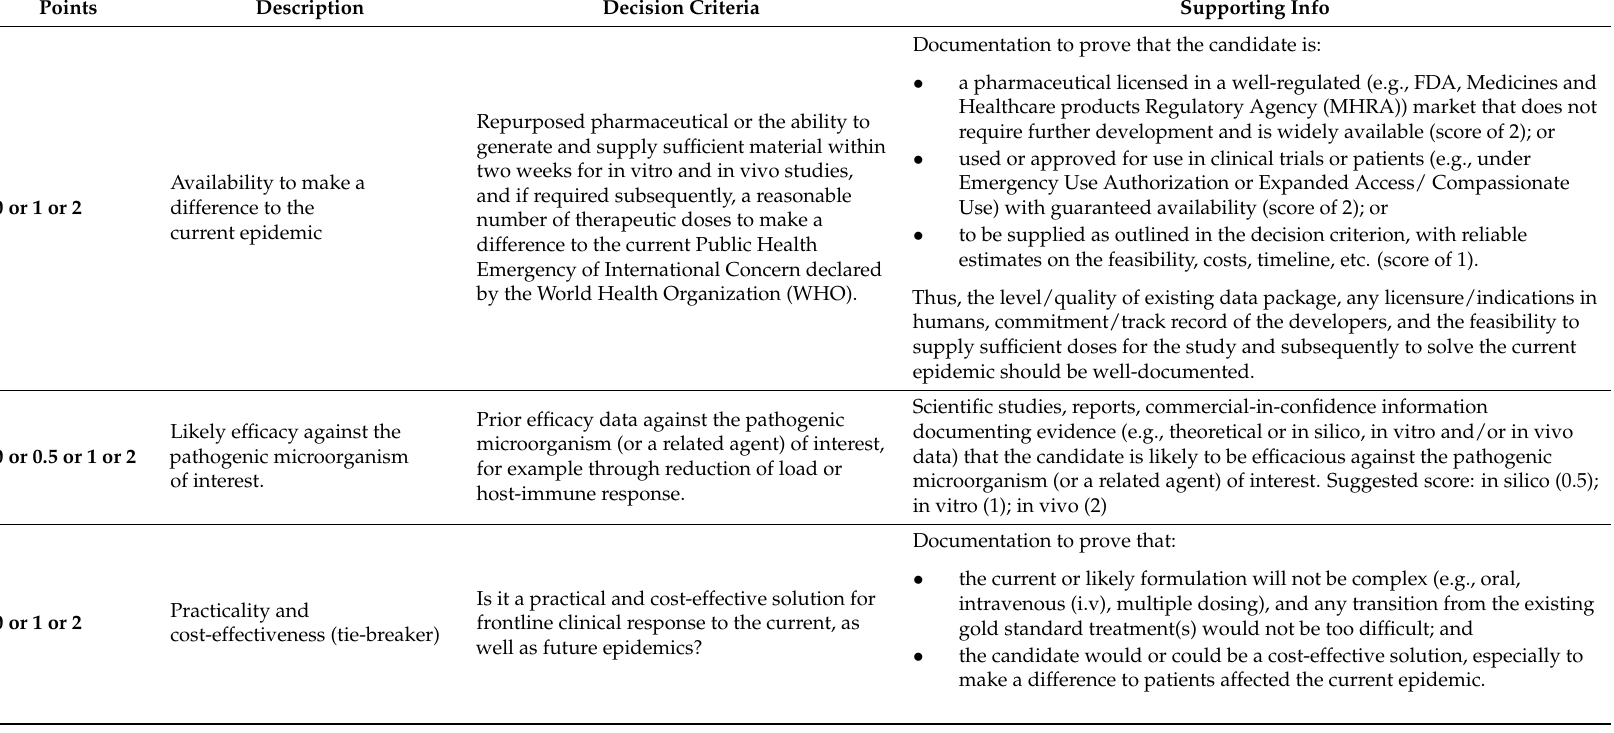
Table A2. Additional Scoring